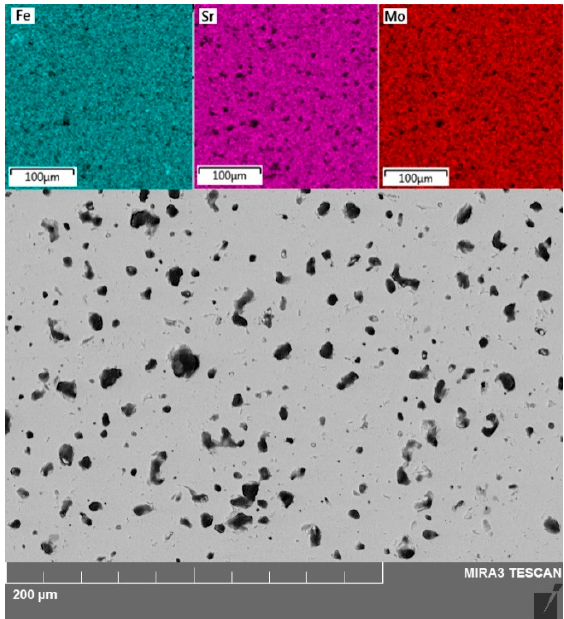
Figure 1. SEM image of Sr 2 Fe 1.5 Mo 0.5 O 6 −δ (SFM) surface and energy dispersive maps for Fe, Sr, and Mo.